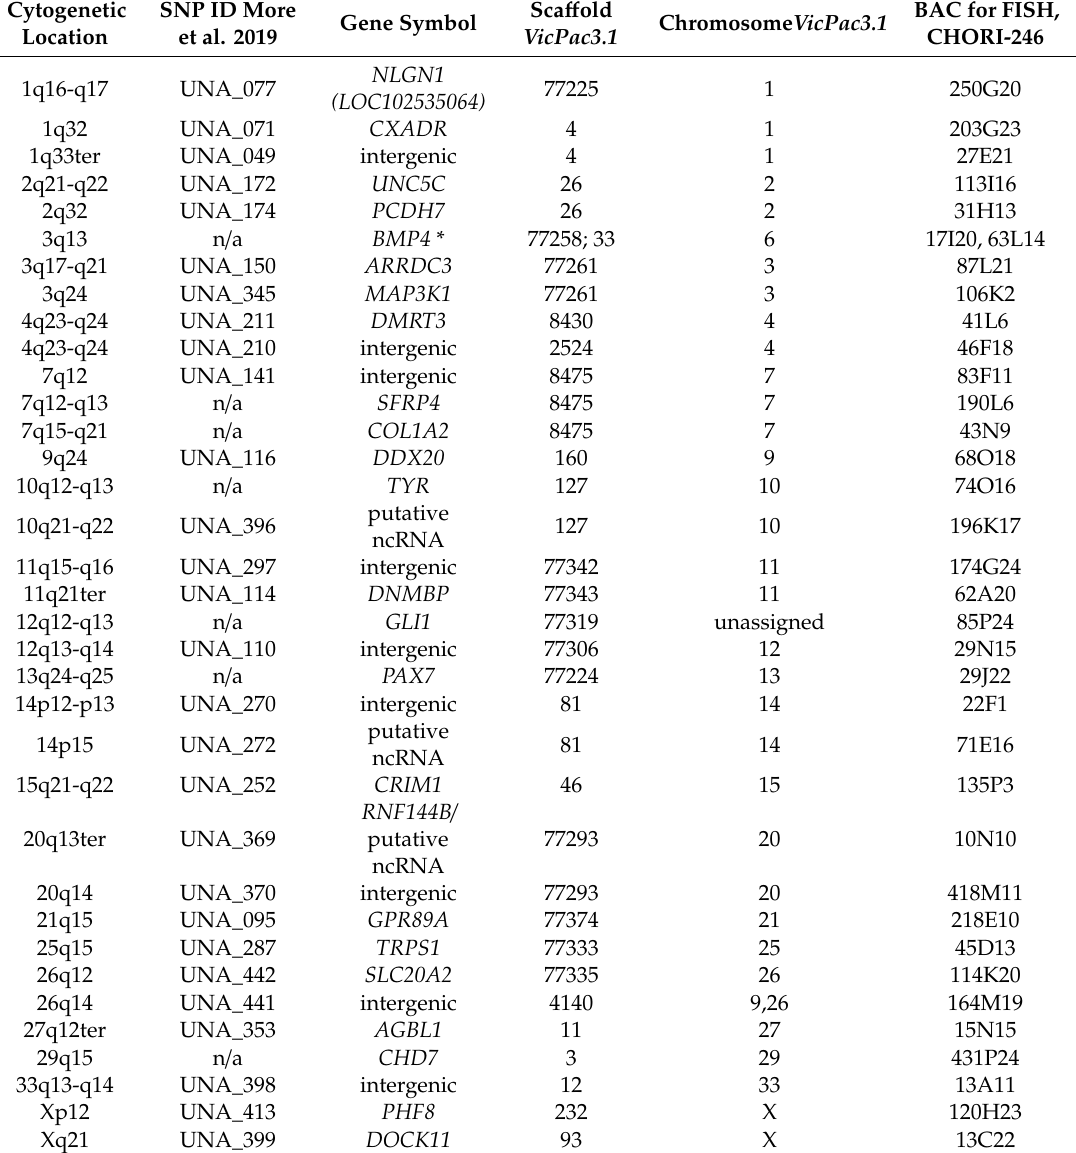
Table 1. Summary information about the cytogenetically mapped SNP markers and genes; *—assignment